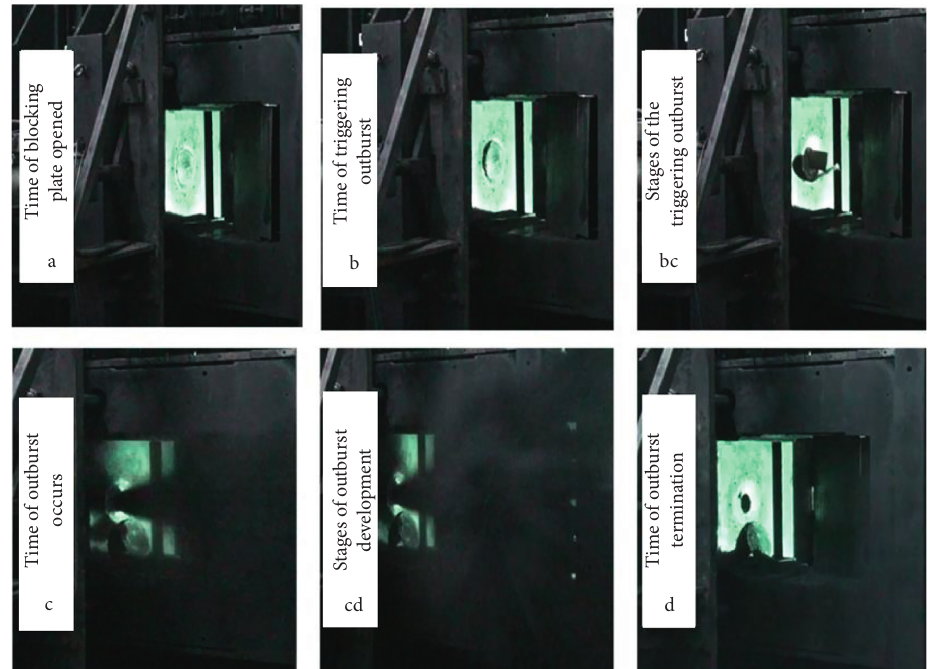
Figure 5: Video screenshots of the delay outburst caused by geostress disturbance.